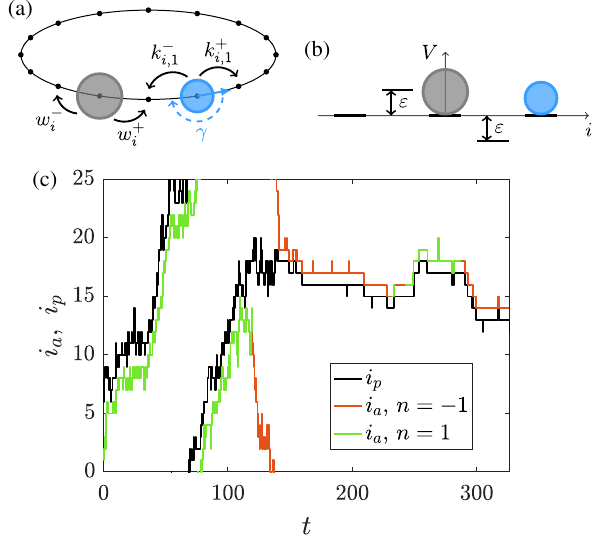
FIG. 2. (a) Setup for the lattice model of an active particle (blue) interacting with a passive one (gray) in a periodic geometry. (b) The particles interact via on-site exclusion and via an asymmetric potential ranging to the next lattice site. (c) Sample trajectories for the passive particle (black line) and the active particle (green or red line, depending on the internal d.o.f.). The active particle first pushes the passive one from behind, until its internal d.o.f. changes direction at t ≃ 120 . Then, after circuiting once around the ring, it hits the passive particle on the attractive other side and sticks to it for the remainder of the shown time 1 , w 1 , γ ¼ 0 . 03 , interval. Parameters: L ¼ 25 , k 0 ¼ 1 , f 0 ¼ ac ¼ ε ¼ 5 , and f 0 . 1 ex ¼